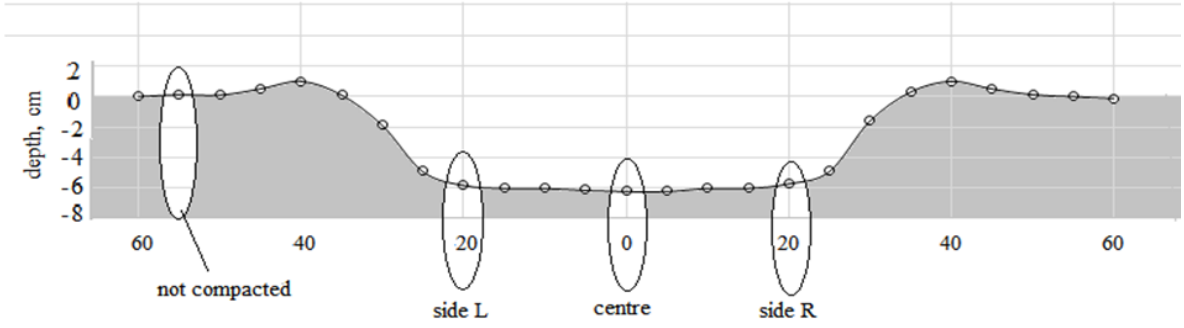
Figure 3. Principal scheme of measurements in tramline profile.